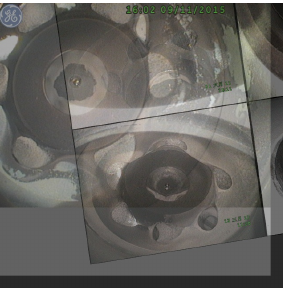
Figure 6. An example of the image after Mosaic and MixUp image